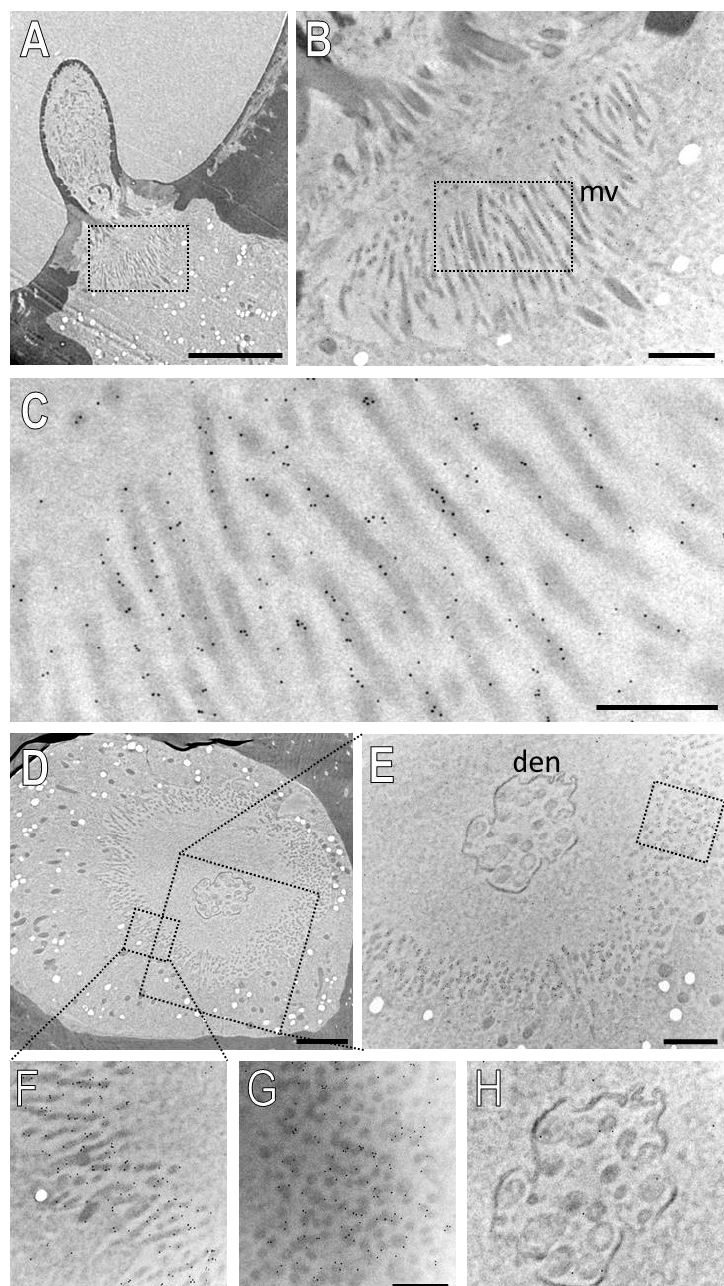
Figure 8. SNMP2 is localized in microvilli of support cells of basiconic sensilla. Ultrathin sections were treated with anti-SNMP2-ab in immunogold labelling experiments and assessed by transmission electron microscopy. ( A ) Longitudinal section through a basiconic sensillum. ( B ) Higher magnification of the region boxed in ( A ), showing microvilli structures (mv) at the base of the sensillum. ( C ) Higher magnified image of the region boxed in ( B ), displaying clear anti-SNMP2-ab immune reactivity associated with microvilli. ( D ) Cross section through the base of another basiconic sensillum. ( E ) Higher magnified image of the large box depicted in ( D ). A higher magnification of the smaller box in ( D ) is shown in ( F ), indicating strong immunogold labelling of microvilli structures. ( G ) is a higher magnification of the microvilli boxed in ( E ), depicting SNMP2-labelling associated with transversely cut microvilli. ( H ) is a higher magnification of the dendrites (den) shown in ( D , E ), indicating only low levels of background signal. Scale bars: ( A ) = 5 µm; ( B , E ) = 1 µm; ( D ) = 2 µm; ( C , F , G , H ) = 500 nm.